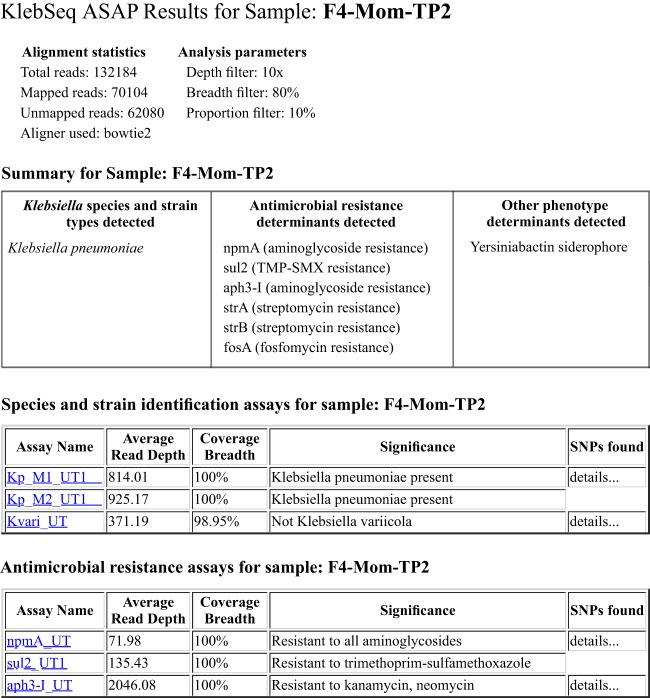
Partial sample output of KlebSeq ASAP report; some AMR gene assays and the virulence gene assays are hidden from view to limit the size of the image. The top box shows a summary of what was detected according to selected ASAP filters. Details of each assay appear below that. If additional SNPs are detected in comparison to the assay reference, hovering over “details…” expands a list of the SNPs. Clicking on an assay name pops up a graph of coverage depth across the reference sequence.